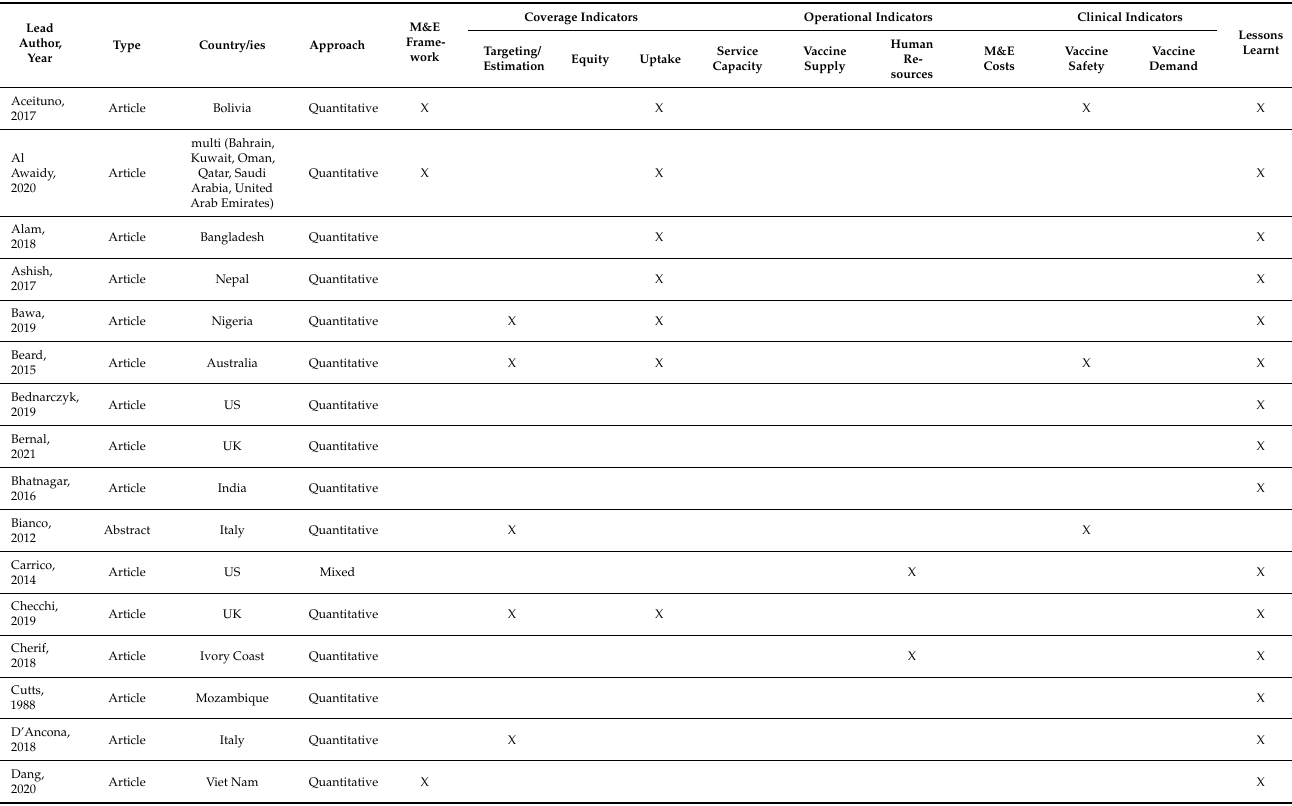
Table 3. Synthesised findings by